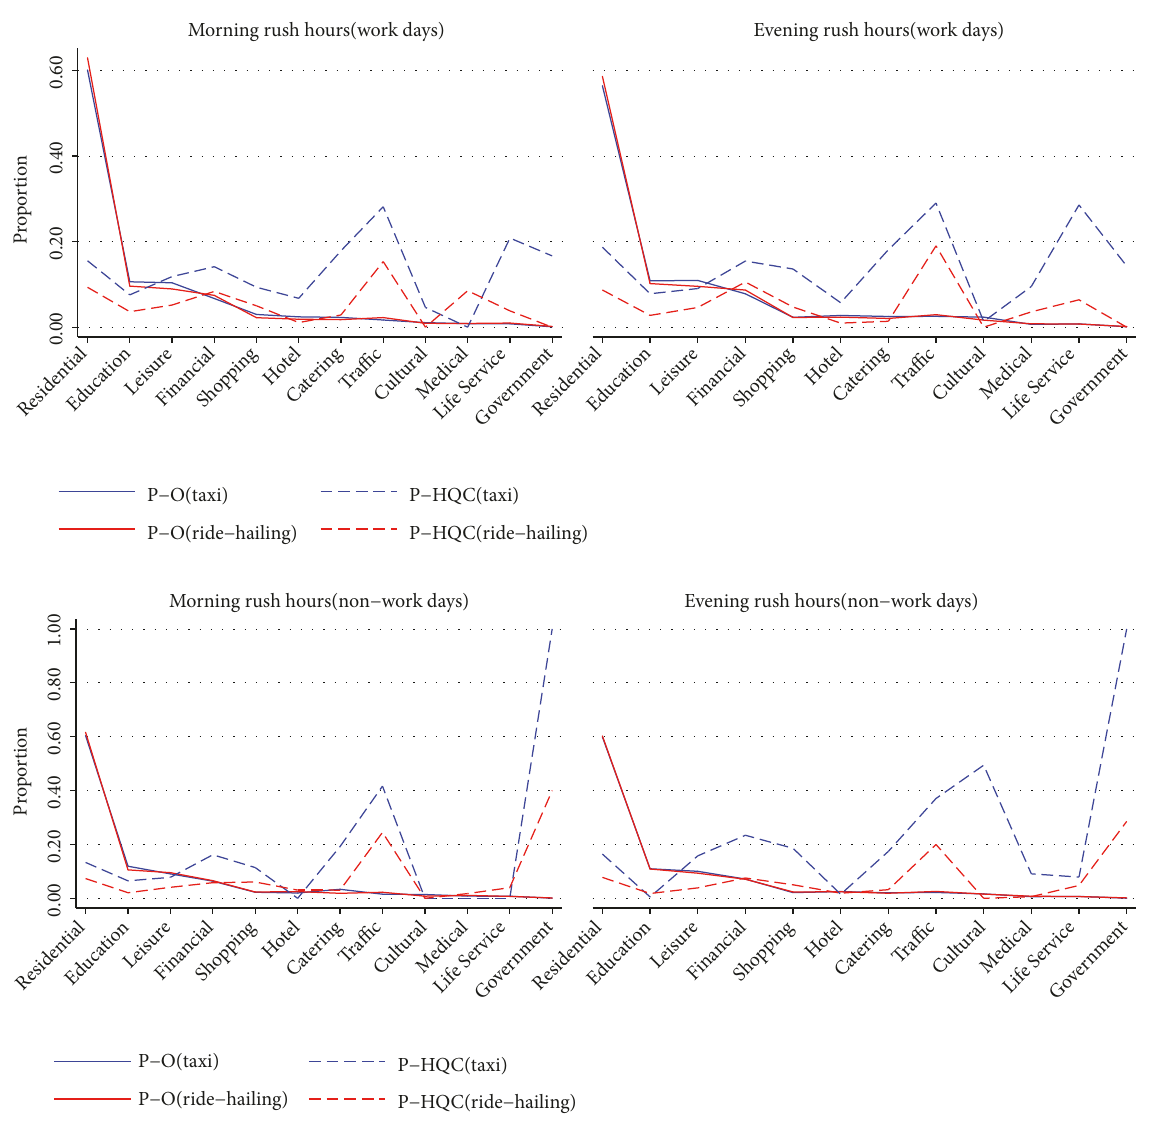
Figure 5: The proportion of orders and HQC in different functional zones on workdays and nonworkdays (taxi and